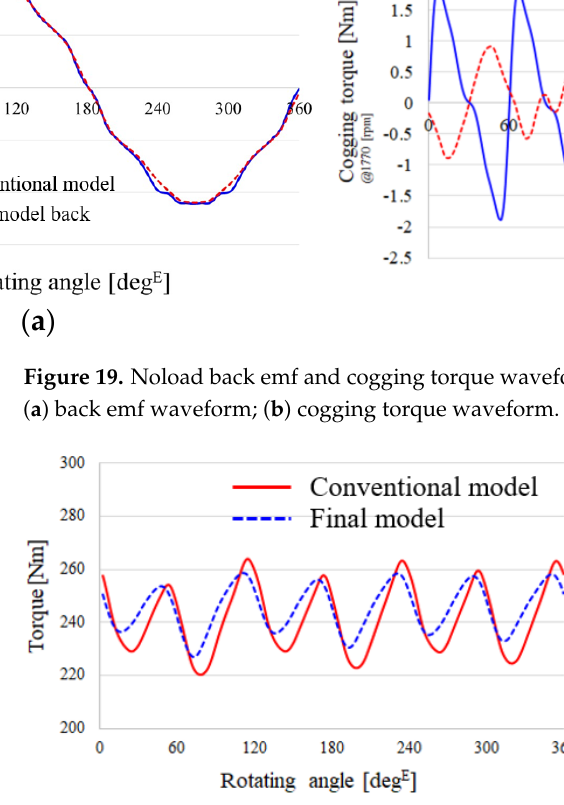
Figure 19. Noload back emf and cogging torque waveforms for conventional model and final model: ( a ) back emf waveform; ( b ) cogging torque waveform.